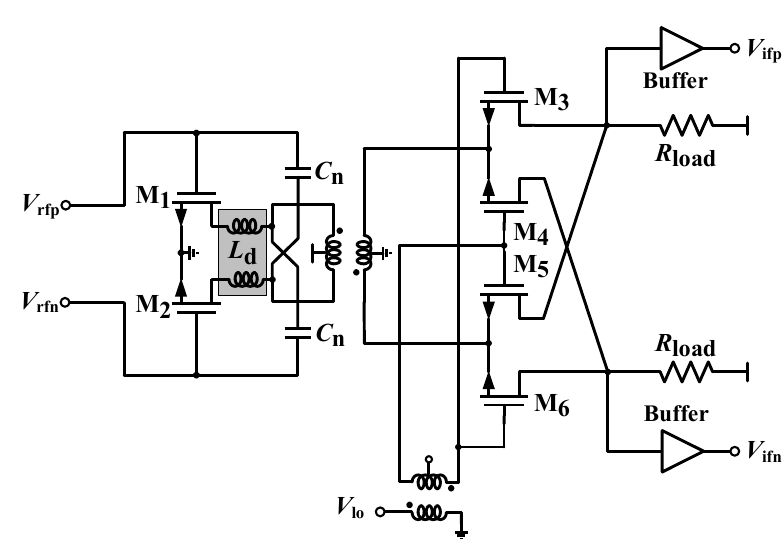
Figure 5. The schematic of the classic mixer.